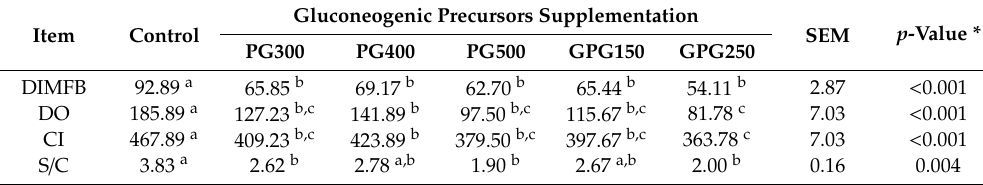
Table 4. E ff ect of di ff erent drenching regimens by gluconeogenic precursors on reproductive performance.